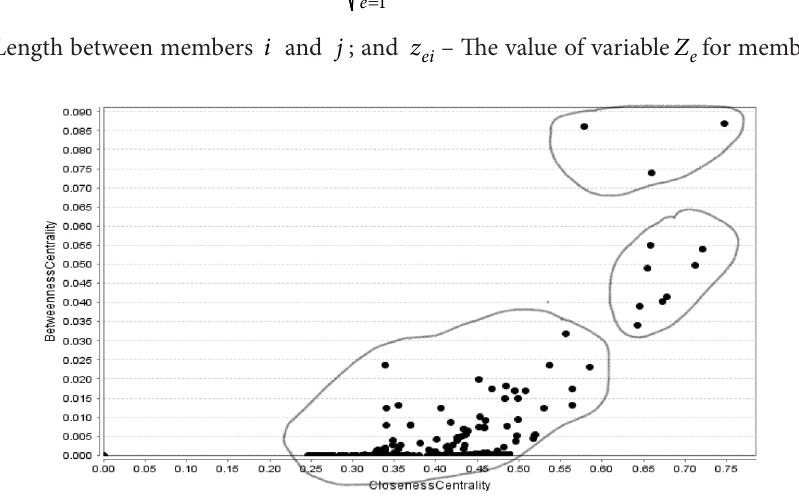
Figure 3. Betweenness centrality and closeness centrality of supply chain